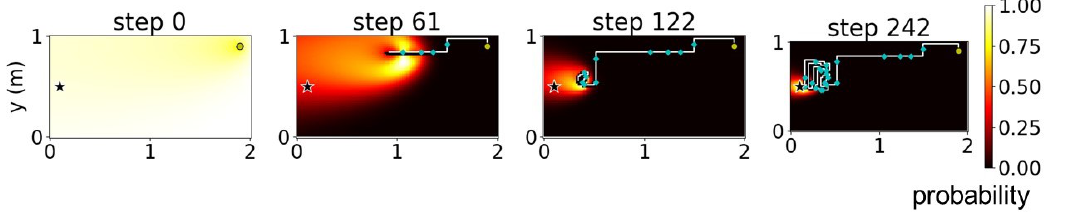
Figure 7. Timeline of a typical odor source localization (OSL) search using the Infotaxis algorithm without environment decomposition (Number of sub-environments ( K ) = 1). The star indicates odor source location.